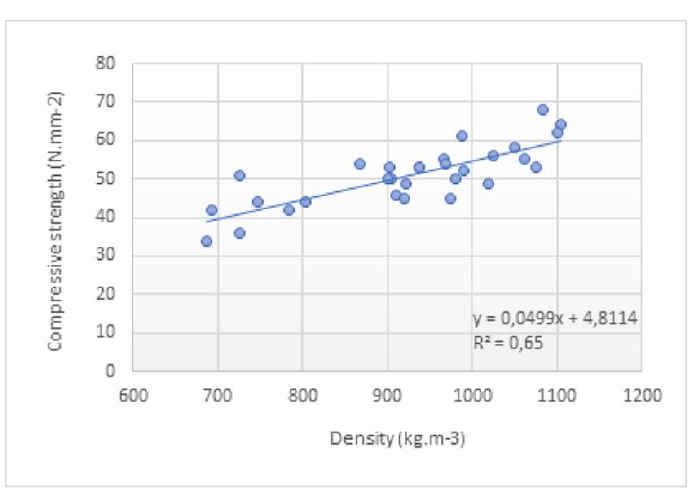
Figure 8. Correlations between compressive strength and density for all sites.